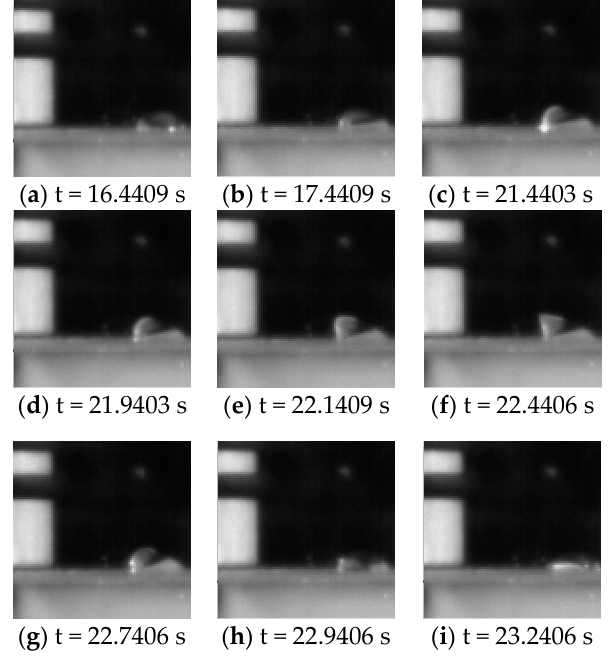
Figure 14. The deformation characteristic of droplet under DC positive polar power source.